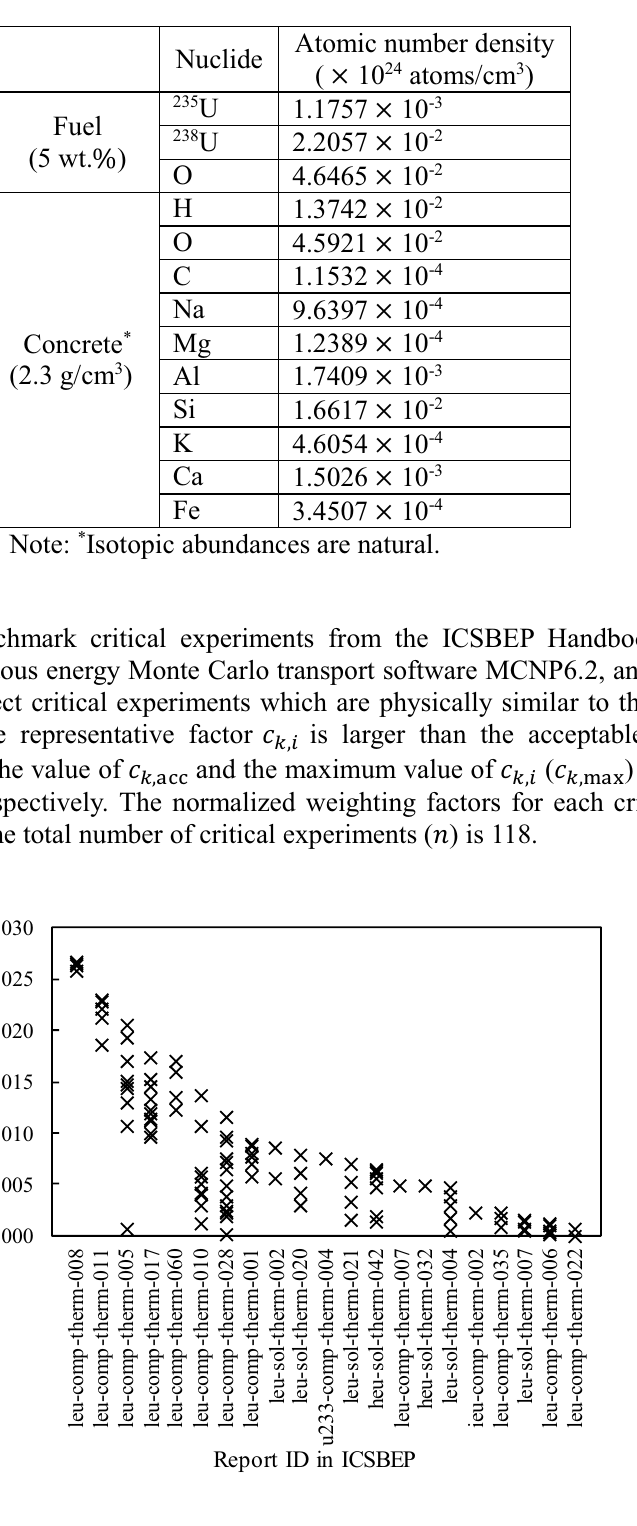
Figure 2. Normalized Weighting Factors for each Critical